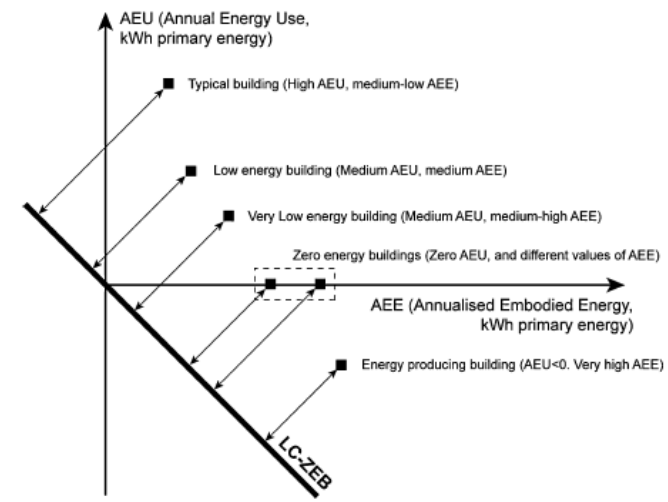
Figure 3. A graphical representation of the zero-energy building concept [23].